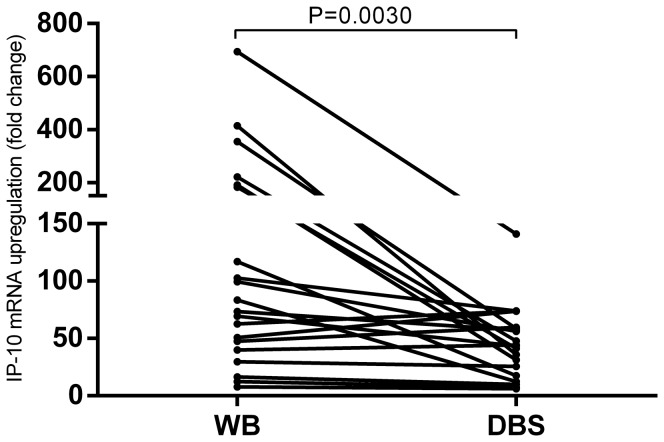
Comparison of mRNA extraction from whole blood (WB) and dried blood spots (DBS).Whole blood from 12 TB patients and 8 LTBI persons was incubated in QFT-TB tubes for 8 hours at 37°C. mRNA was extracted directly from WB and DBS samples were prepared for later mRNA extraction. IP-10 gene expression was determined using our RT-qPCR assay. The difference was analysed using a Wilcoxon matched pairs test p = 0.003.